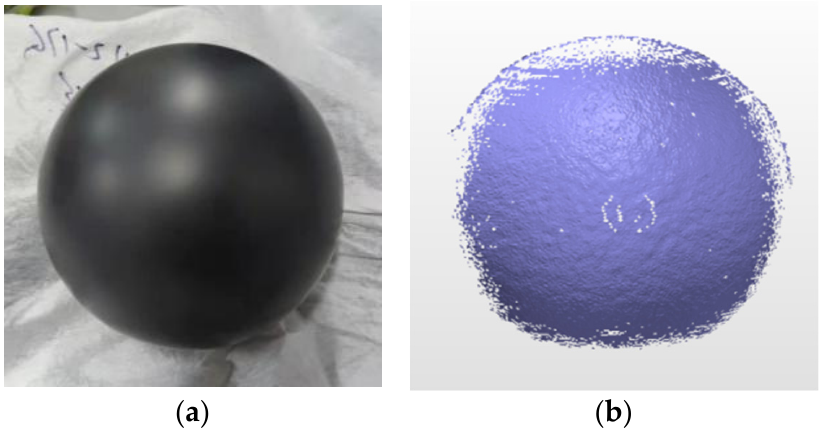
Figure 4. ( a ) Photograph of the black standard ceramic sphere with matte surface, and ( b ) point cloud obtained by point scanning system.